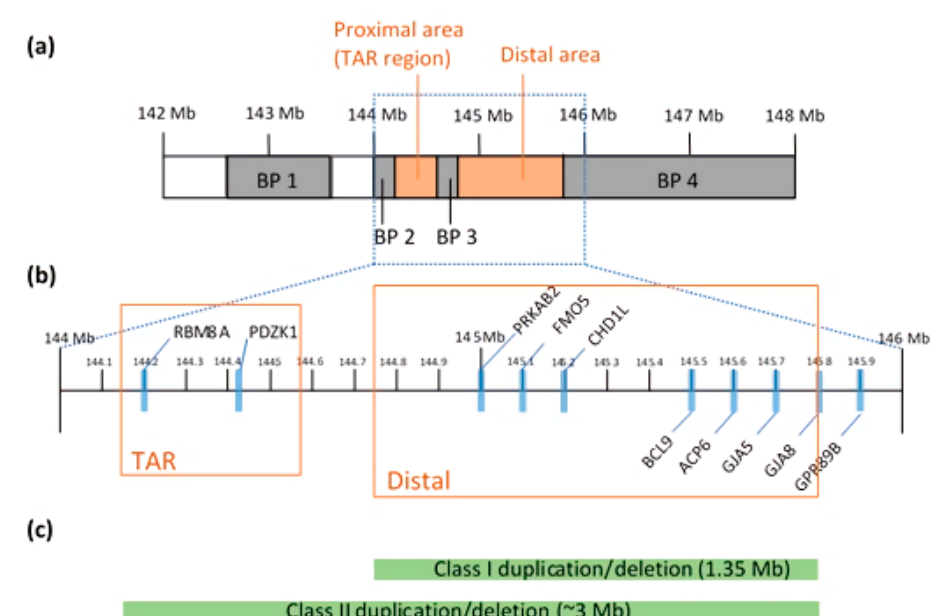
Figure 1. ( a ) Chromosomal structure of 1q21.1, mapped with four BPs (gray) and two distinct regions (red). ( b ) An enlargement of the region between 144 Mb and 146 Mb. Known genes commonly found in microduplication and microdeletion carriers are marked with blue bars. The reference locations on the chromosome are based on the March 2006 human reference sequence (NCBI build 36.1). The two distinct regions—TAR and Distal—are indicated by red blocks. ( c ) The two classes of duplications and deletions are shown with green bars. The size of the bars represents the minimally affected region in each class.